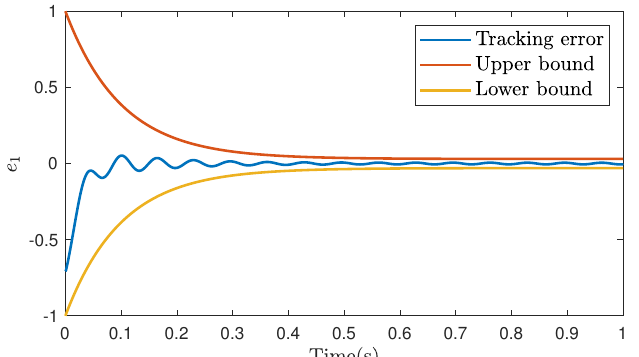
Figure 4. An example of the prescribed time-varying tracking performance with ρ 0 = 1, ρ ∞ = 0.03, υ = 1, υ = 1, and φ =